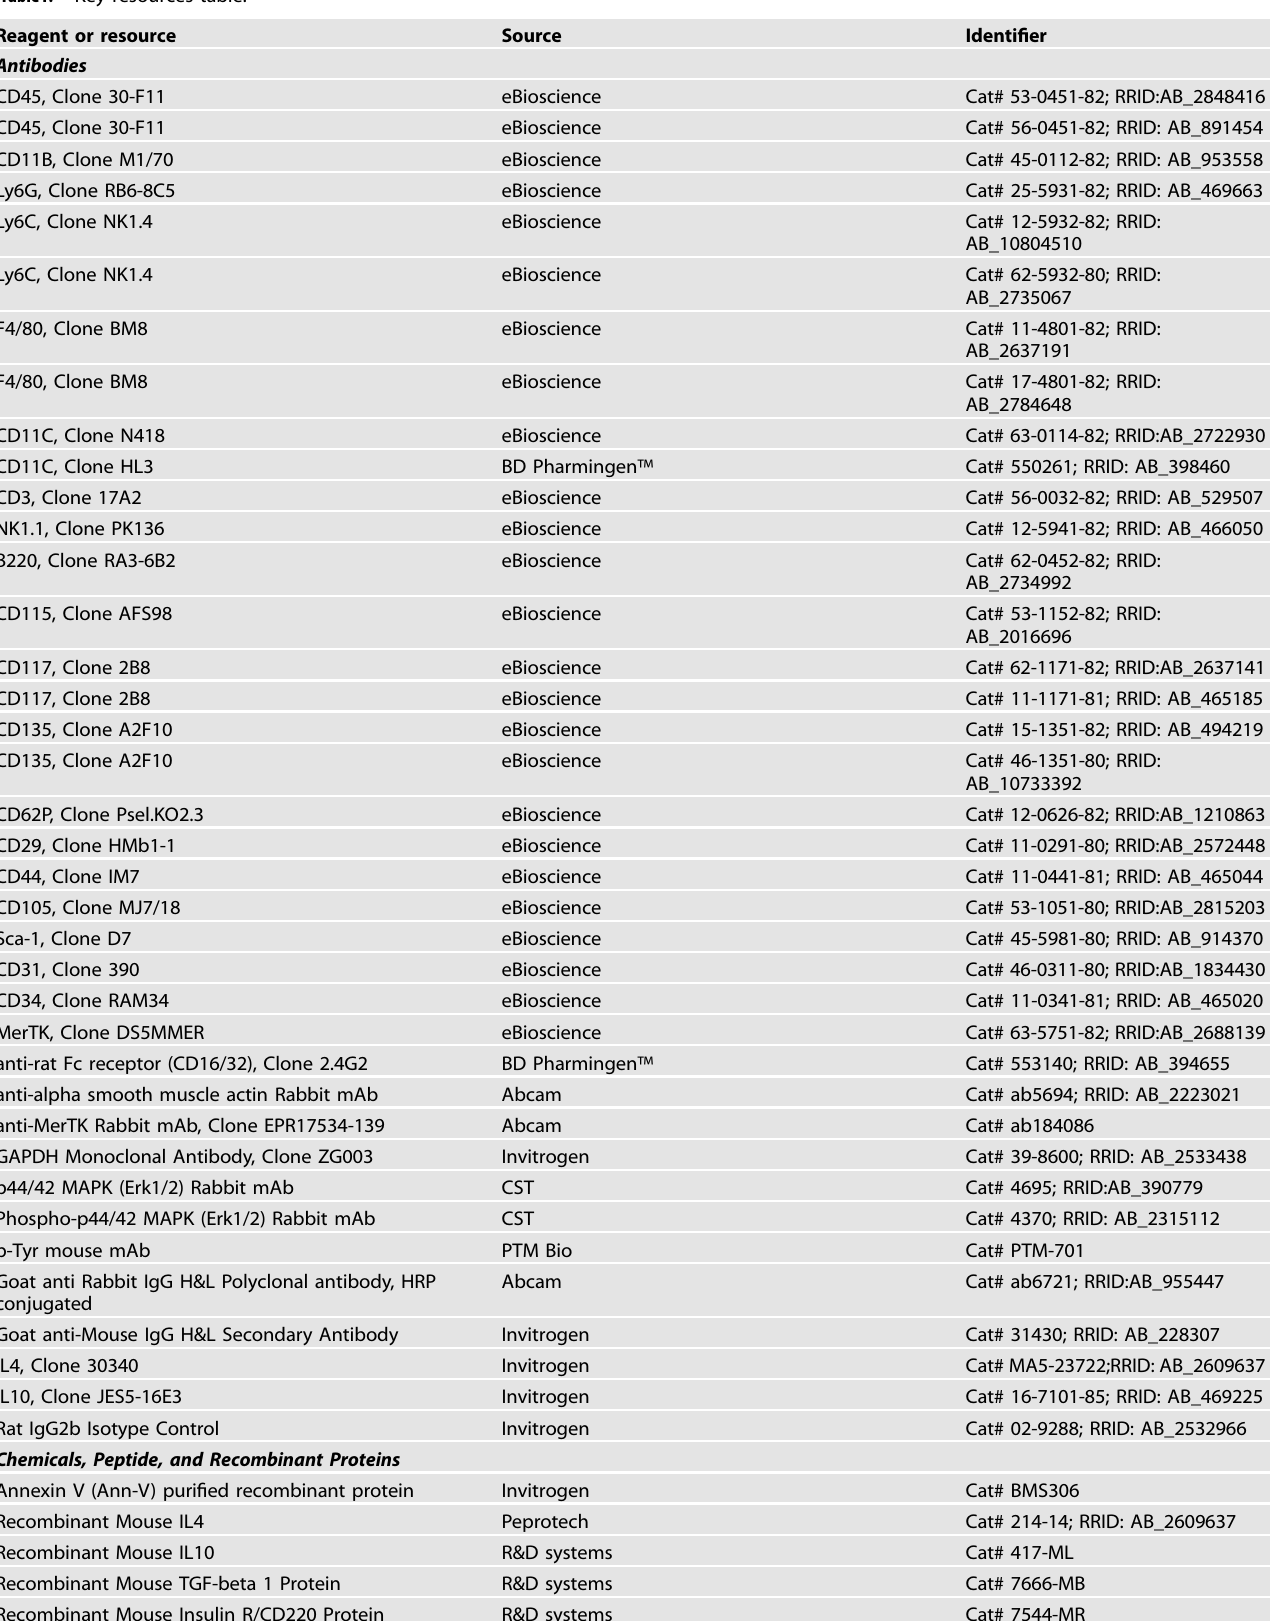
Table1. Key resources